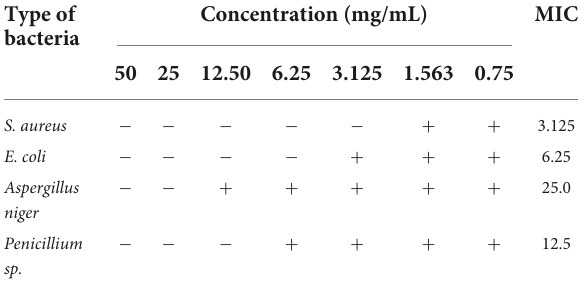
TABLE 1 Evaluation of antibacterial activity of purified anthocyanin. Type of bacteria